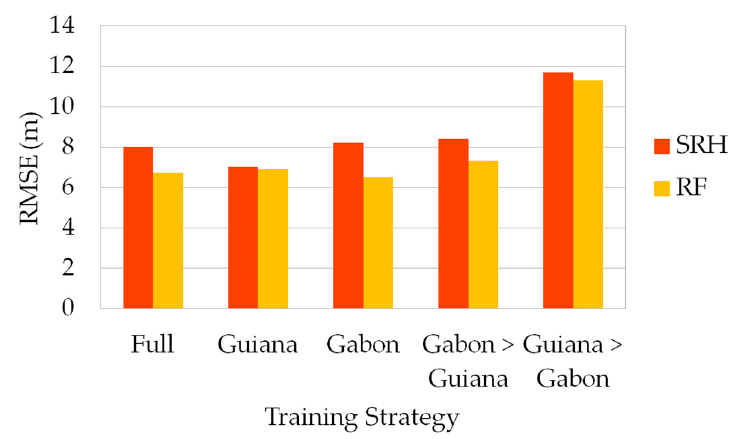
Figure 10. RMSE for GEDI-CHM SRH and RF estimators depending on training/validation strategies (algorithm setting group number 5).